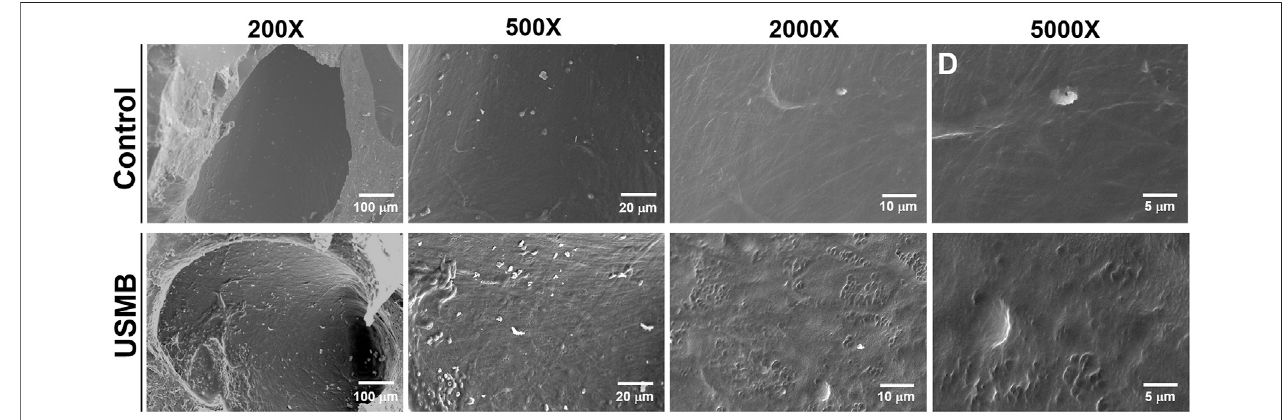
FIGURE 4 | Scanning electron micrographs of the epithelial surface of the RWM under various magni fi cations. RWM samples in the USM group were immediately taken from the animal after three exposure courses of USMBs. Samples from animals after MB soaking of the tympanic bulla for the same period without US exposure served as controls. USMB, ultrasound microbubble.